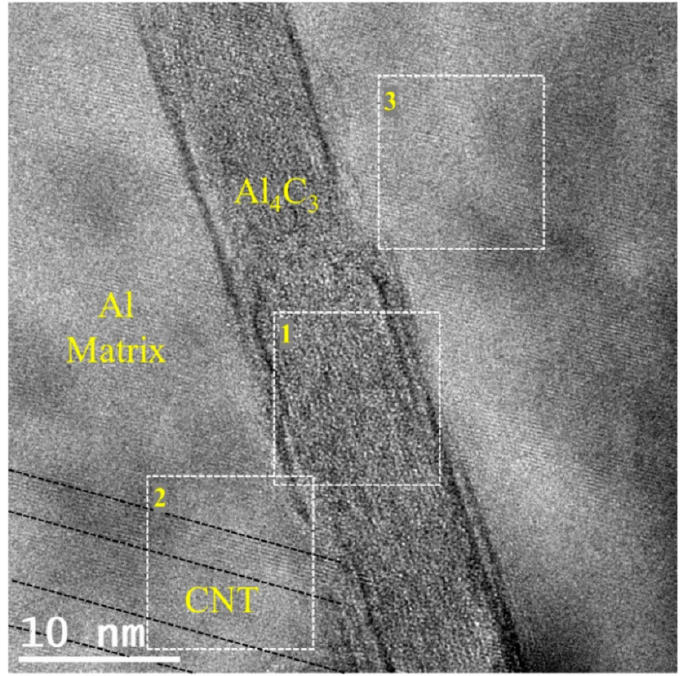
Figure 7. HRTEM image and inverse FFT showing the Al 4 C 3 and CNT embedded in the Al matrix [129].